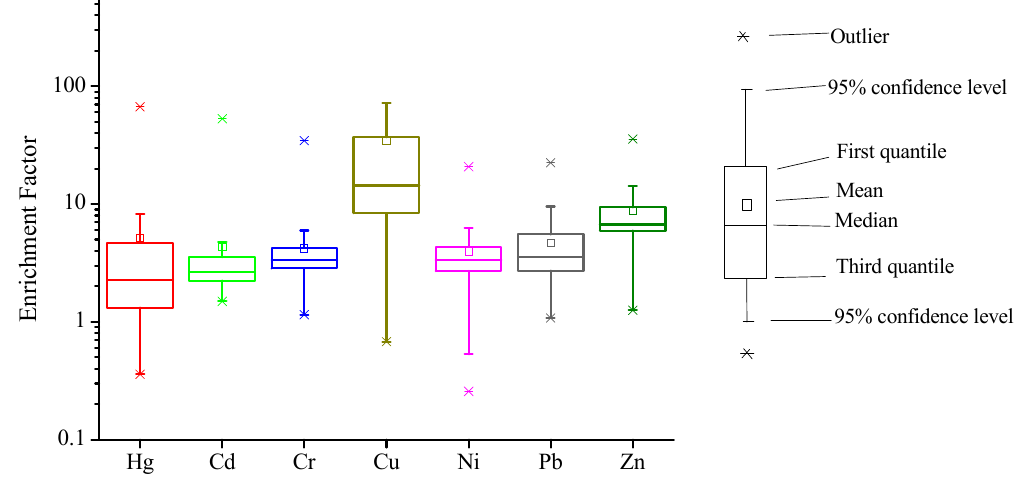
Figure 3. Heavy metal enrichment factors of atmospheric settled dust in Qingdao City.